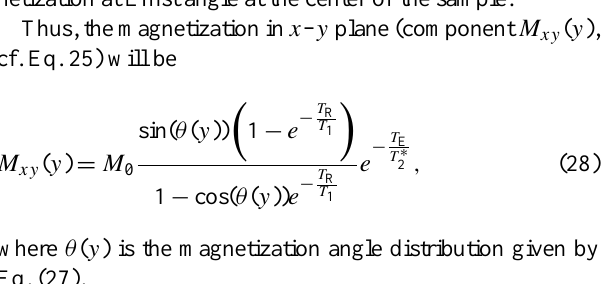
Figure 4. Magnetization vector representation in the static